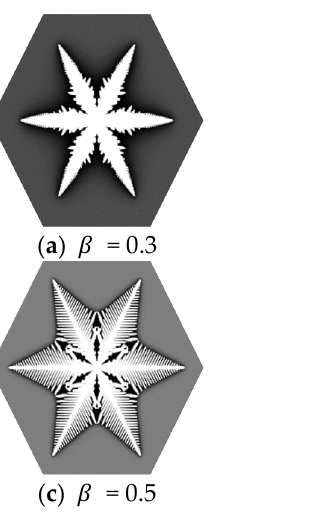
Figure 7. Morphology of snowflakes with a different β parameter.